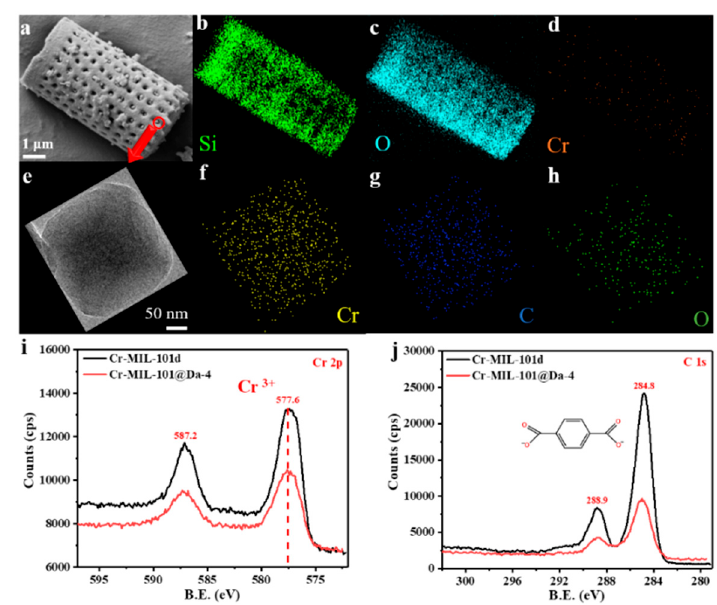
Figure 4. ( a – d ) SEM images and EDS elemental mapping analysis of Cr-MIL-101@Da-4, ( e – h ) TEM images and EDS elemental mapping analysis of the embedded Cr-MIL-101 particle in Da, ( i , j ) high-resolution XPS spectra of the Cr 2p, C 1s core level of Cr-MIL-101@Da-4 and Cr-MIL-101d. Table 2. Adsorption–desorption parameters measured for Cr-MIL-101 and Cr-MIL-101@Da.